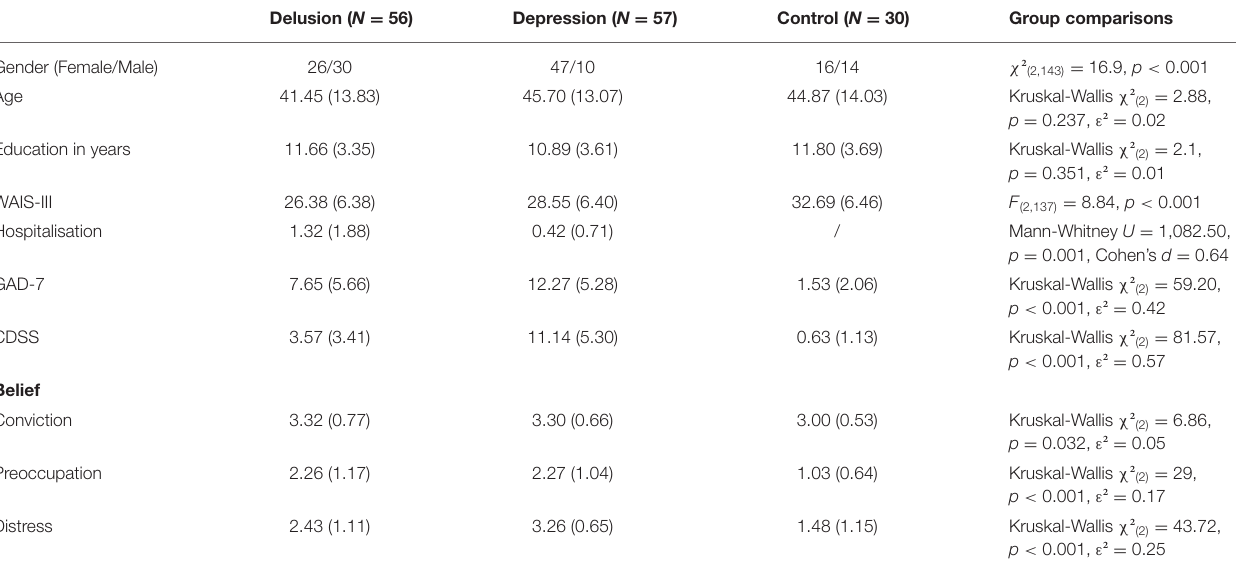
TABLE 2 | Demographic characteristics and emotion